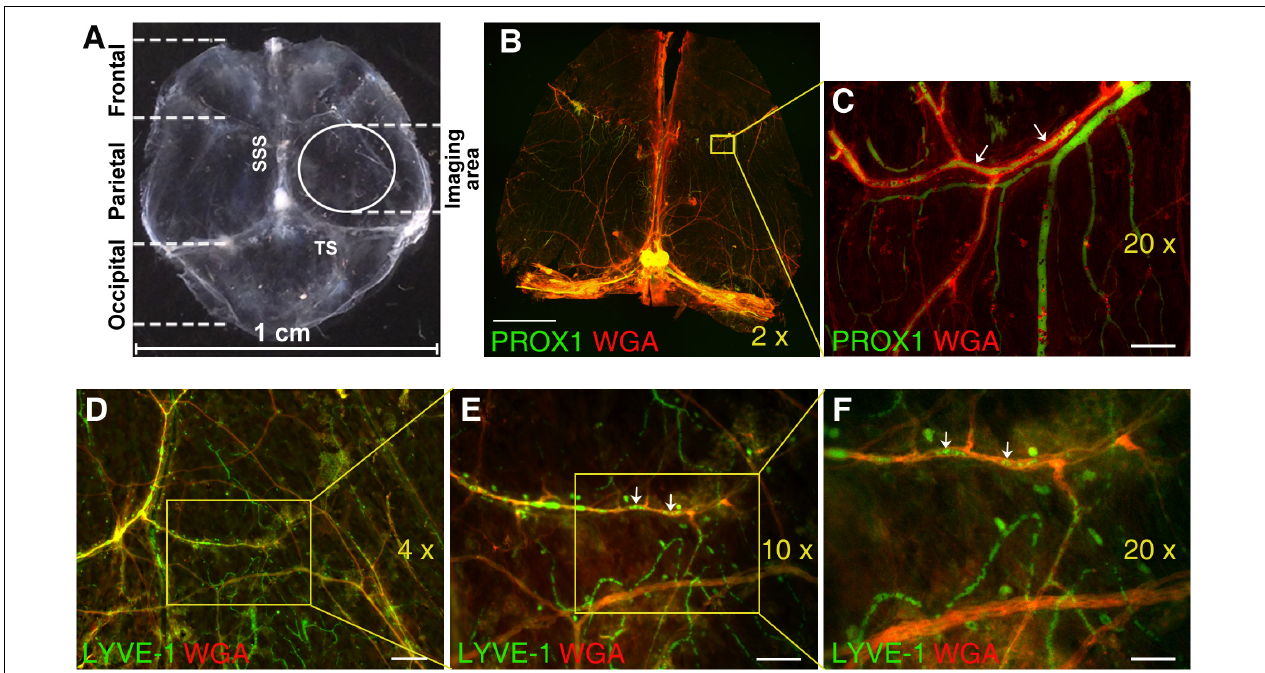
FIGURE 1 | Immunofluorescence analysis of mouse dura mater non-sinus-associated blood and lymphatic microvessels. (A) Isolated mouse dura mater completely separated from the skull. SSS, superior sagittal sinus; TS, transverse sinus. (B) Stitched image of the whole mount of Prox1eGFP mouse dura matter immunostained with AlexaFluor 594-conjugated WGA lectin (red) to visualize blood vessels and imaged using 2 × objective. Yellow inset outlines the area imaged with 20 × objective and shown in (C) . (C) Detailed view of PROX1-positive lymphatic vessels (green) and WGA-positive blood vessels (red) in parietal area of dura mater. (D) Through (F) Immunofluorescence images of dura mater blood and lymphatic microvasculature in parietal area of wild type mouse dura mater acquired with 4 × (D) , 10 × (E) , and 20 × (F) lenses. Isolated mouse dura mater was stained with anti-LYVE-1 antibody (green) for lymphatic and WGA lectin (red) for blood microvessels. In (C,E,F) please note green structures within red stained blood vessels (arrows), which could represent potential artifacts due to auto fluorescence of blood cells trapped in the vasculature. Scale bars, 2000 µ m (B) , 50 µ m (C) , 200 µ m (D) , 100 µ m (E) , and 50 µ m (F)